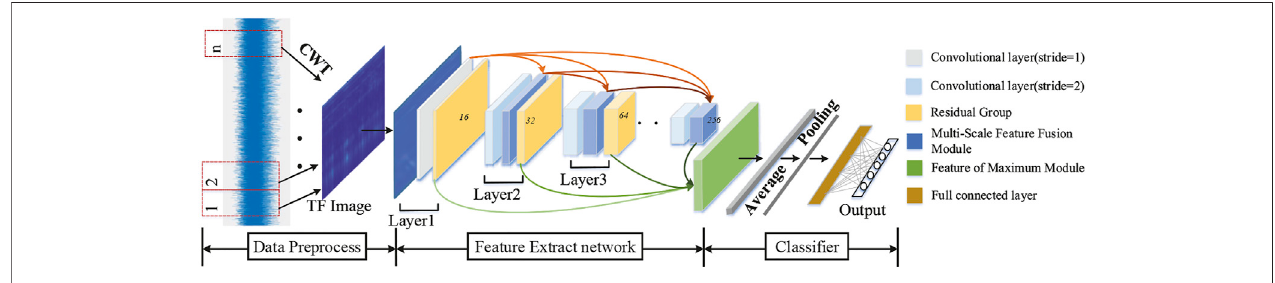
FIGURE 1 | The process of MSDFN-based fault diagnosis.